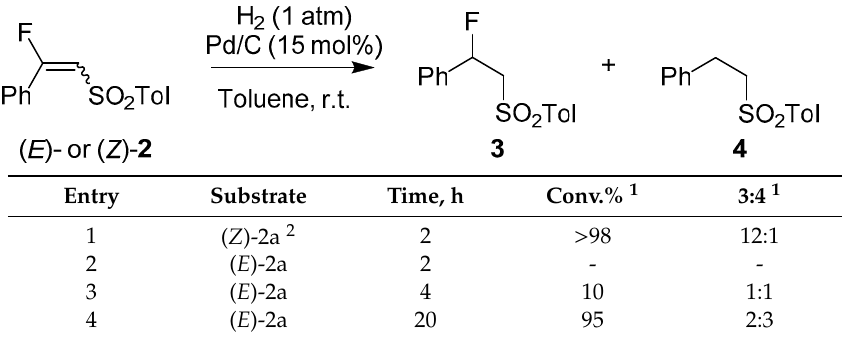
Table 2. A comparison of the hydrogenation of both ( E )- and ( Z )-fluorovinyl sulfones.